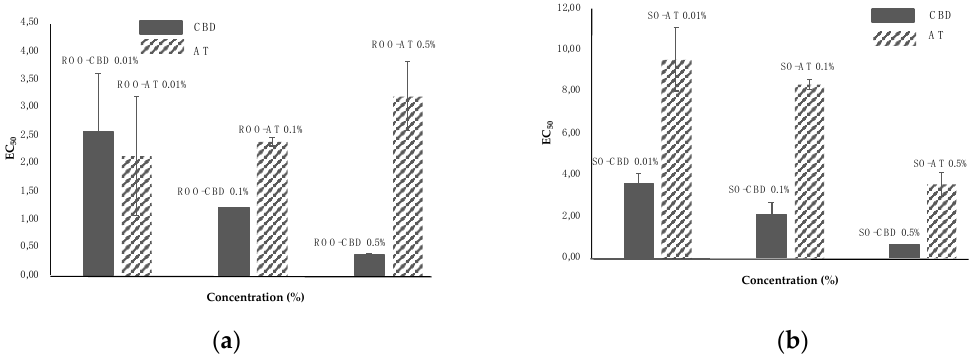
Figure 2. Differences in EC 50 values of DPPH • obtained by adding CBD or α-tocopherol to refined olive oil (ROO) on the left ( a ), and to samples obtained by adding CBD and α-tocopherol to sunflower oil (SO) on the right ( b ). A lower value of EC 50 corresponds to higher scavenging activity.